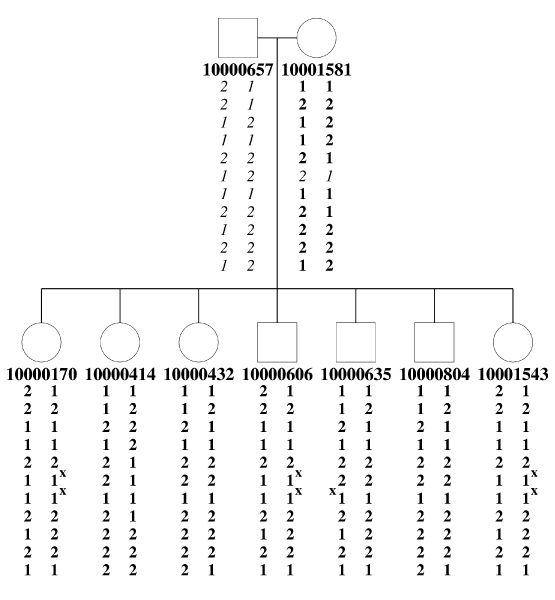
Inferred haplotypes for markers 175 to 185 for the core part of pedigree 10043. Italics indicated that genotypes were reconstructed. 'x' marks the interval where a recombinant is inferred to have occurred. The actual double recombinants are probably persons 10000432, 10000635, and 10000804 for reasons given in the text. The physical distance between the SNPs flanking the double recombinants is 1.57 Mb.